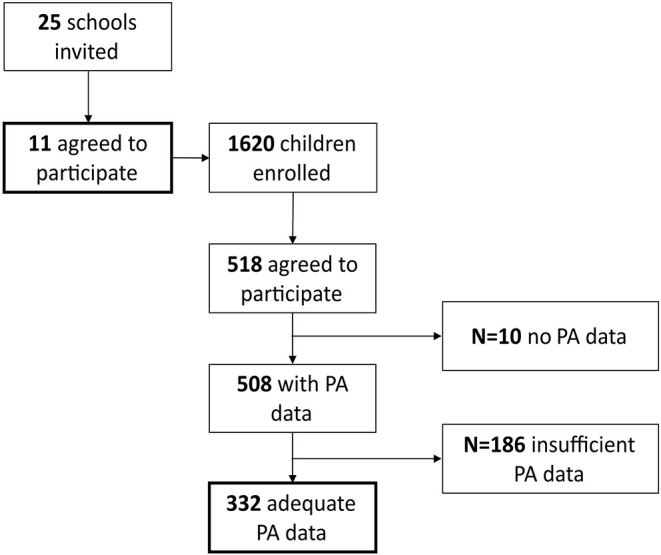
Flow chart of the sample selection process.